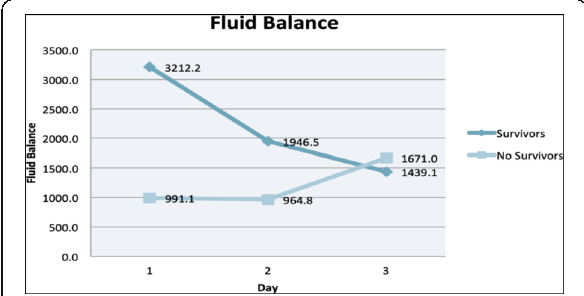
Fig. 3 (abstract 001048). See text for